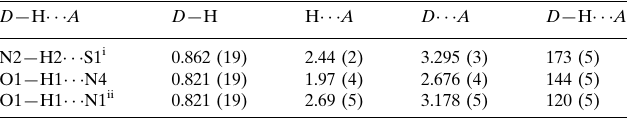
triazole rings and of the benzene rings (centroid–centroid